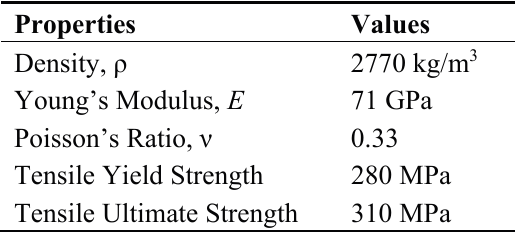
Table 2. Material properties of the aluminum used in the C-Part